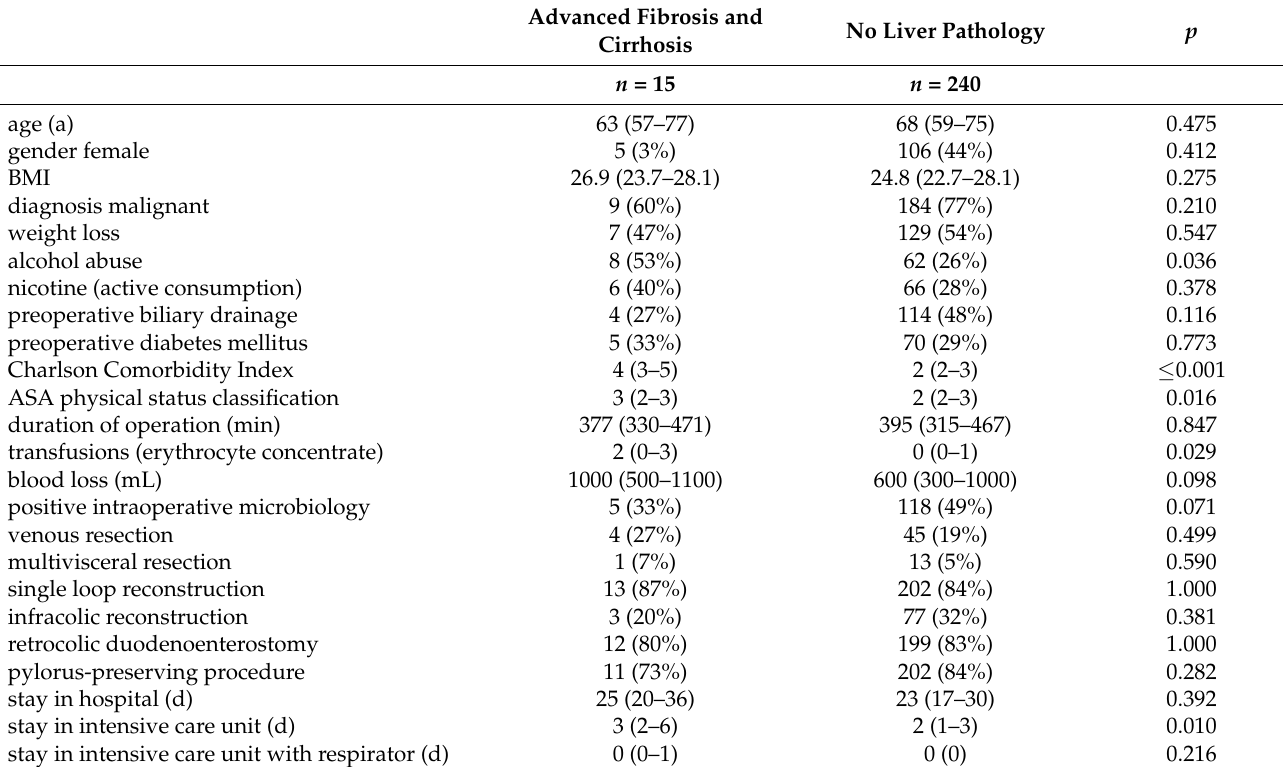
Table 1. Demographic and perioperative data.